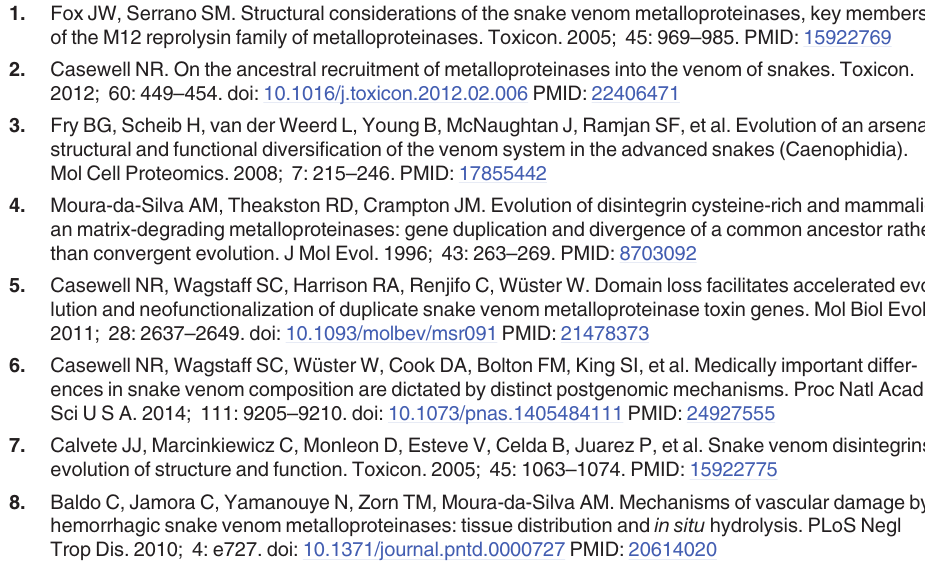
S3 Table. Coagulation factors identified in wound exudates collected from mice injected with PI, PII or PIII SVMPs. S4 Table. Serum proteinase inhibitors identified in wound exudates collected from mice in- jected with PI, PII or PIII SVMPs. S5 Table. Intracellular proteins identified in wound exudates collected from mice injected with PI, PII or PIII SVMPs. S6 Table. Keratins identified in wound exudates collected from mice injected with PI, PII or PIII SVMPs. S7 Table. Membrane proteins identified in wound exudates collected from mice injected with PI, PII or PIII